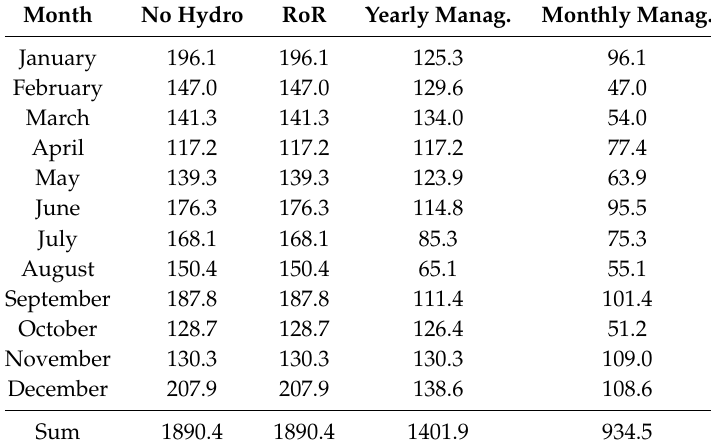
Table 2. Peak hourly power dependence from the grid for four different options (kW). No Hydro: without hydropower; ROR: run-of-river; and Manag.: management. Month No Hydro RoR Yearly Manag. Monthly